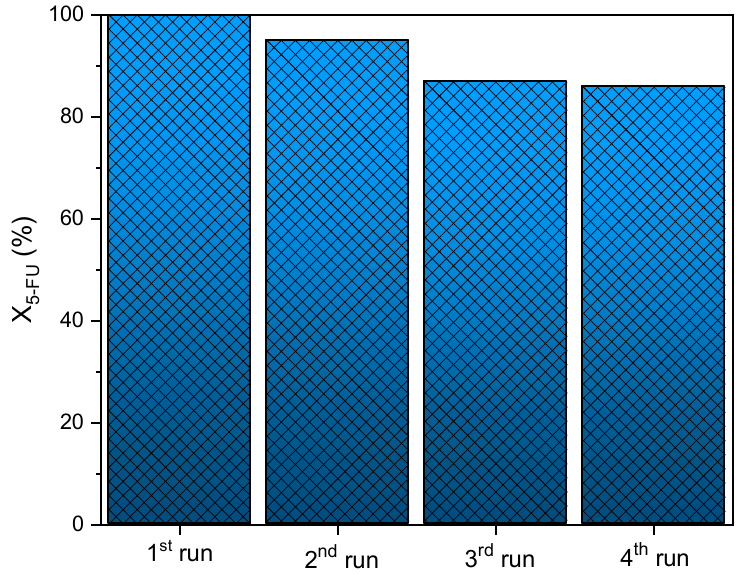
Figure 9. Reusability of CN25/ZnO photocatalyst for the 5-FU degradation during four consecutive cycles. Table 3. Compilation of recently published works regarding g-C 3 N 4 /ZnO composites for the photo- degradation of pollutants in aqueous solution.